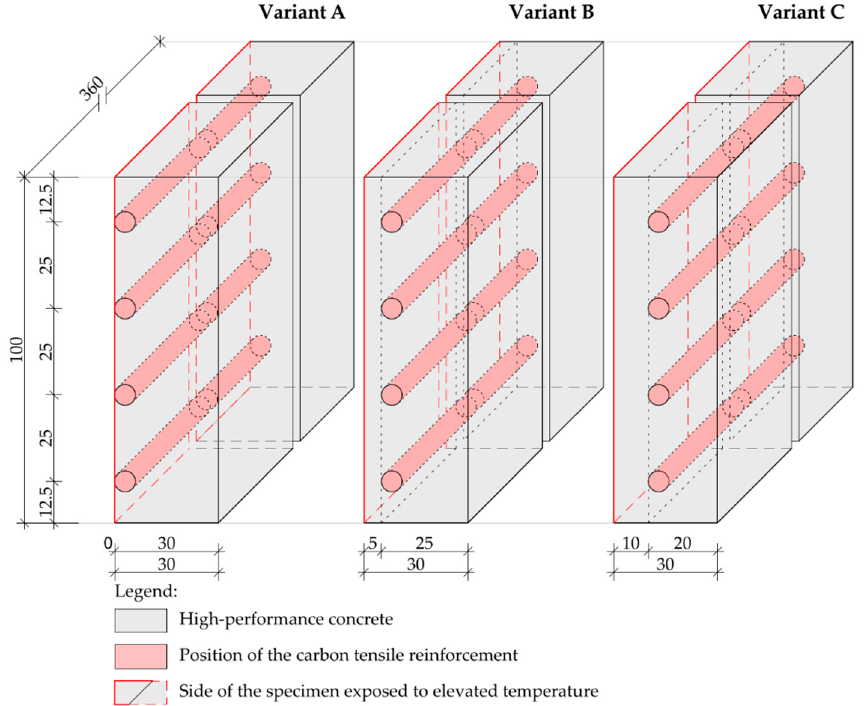
Figure 3. Scheme of the test plate specimens and position of the tensile reinforcement Legend: Variant A—plate specimens with 0 mm covering layer used for direct exposure of textile reinforcement to fire Variant B—5 mm covering layer as minimum possible covering layer regarding the interaction between the materials Variant C—standard 10 mm covering layer of TRC structures. Table 3. Material data of carbon reinforcement.